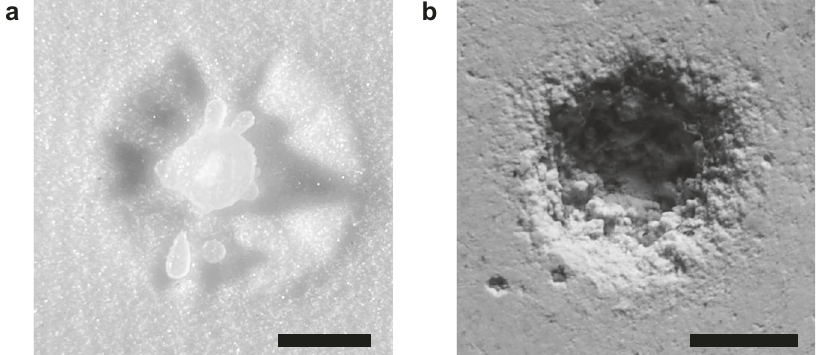
Fig. 1 Erosion by dripping drops. a Erosion crater by drop impact on a granular medium made of 90 μ m glass beads. The crater is created by the impact of a single water drop of diameter D = 3 mm at impact velocity U = 2.97 m/s. b Erosion crater by drop impact on a plaster slab. The crater is created by 2500 repeated impacts of water drops of D = 3 mm at U = 2.6 m/s. Scale bars: 5